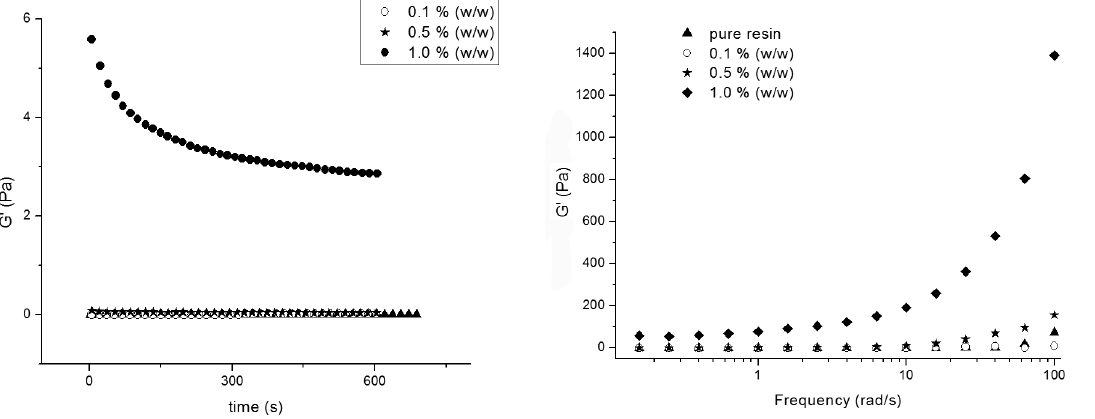
Figure 4. Elastic modulus (G’) as function of time for all CNTs- epoxy